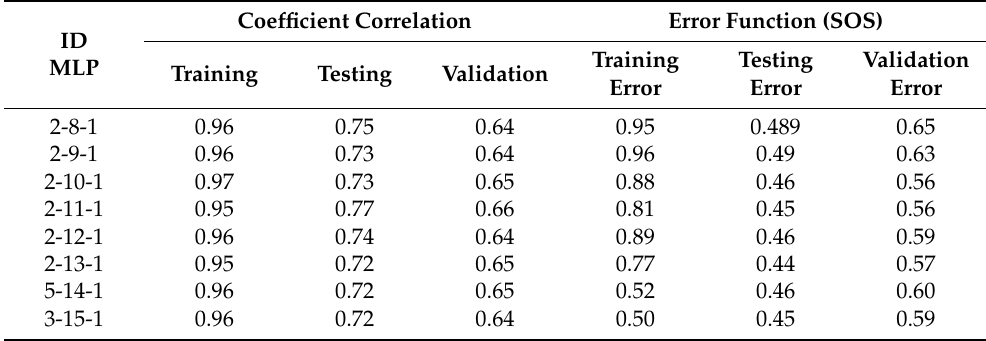
Table 4. Pearson’s coefficients of linear correlation for learning, testing and validation sampling and errors for learning, network testing and validation sampling.